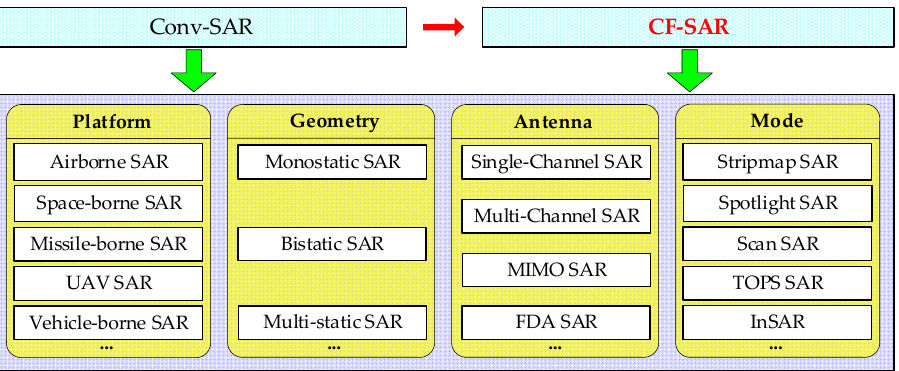
Figure 2. Schematic diagram of the classification of CF-SAR. The full names of some acronyms are as follows: UAV is unmanned aerial vehicle, MIMO is multi-input multi output, FDA is frequency diversity array, TOPS is terrain observation by progressive scans, and InSAR is interferometric SAR.